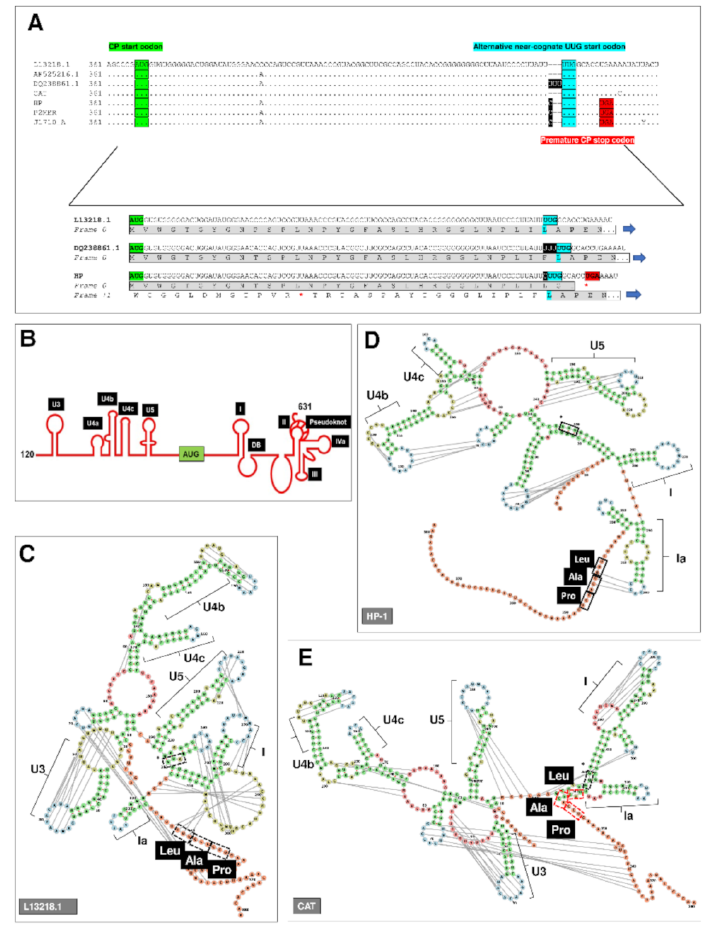
Figure 2. Alternative translational starting site for the GLV capsid protein. ( A ) Upper panel: multiple alignment of the first 114 nt of the GLV-CP ORF. Capsid protein AUG start codon as originally proposed [29] is green boxed. Nucleotide insertion in the GLV genomes are black boxed and the resulting premature stop codon in the capsid protein ORF is red boxed. The alternative near-cognate UUG codon is boxed in light blue. Lower panel: the CP ORF and the corresponding amino acid translation frames for GLV HP ; DQ238861.1 and the reference L13218.1 are reported. Stop signals in the amino acid sequence are indicated by red asterisks (*). Continuation of translation is indicated by blue arrows. ( B ) Structural model of the IRES in GLV mRNA as originally proposed (adapted from Garlapati and Wang, 2004) [17]. The U3 pseudoknot (nt 134–176) and the upstream stem-loops